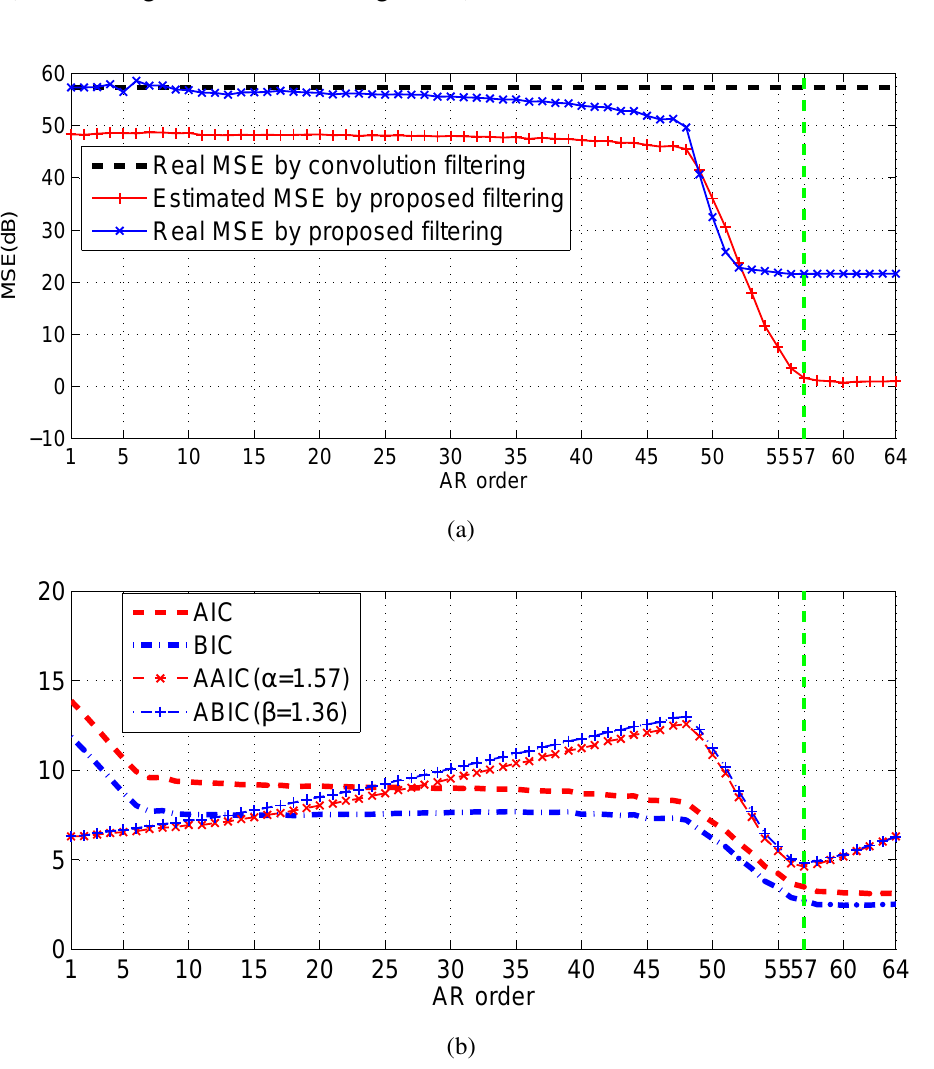
Figure 7. Mean square error of filtering and order selection: ( a ) quantitative comparison of the filtering error by convolution filtering and the proposed filtering; ( b ) comparison of the information criteria, including AIC, BIC, AAIC and